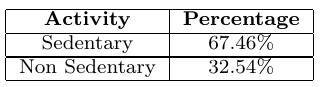
Table 2: Activity share in an eight hour